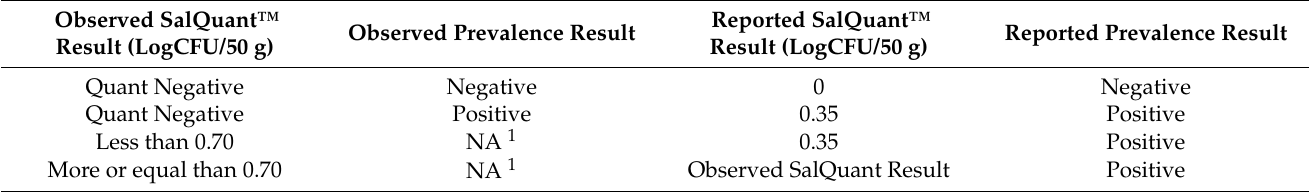
Table 5. Observed and reported parameters established for Salmonella quantification and prevalence analysis for pork trim and ground pork.